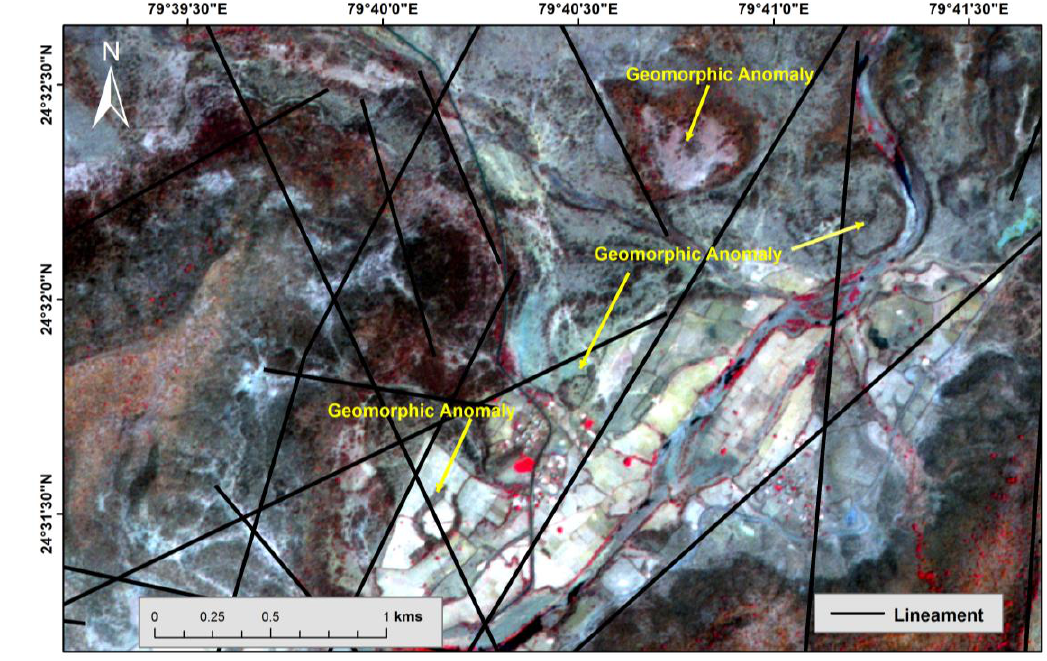
Figure 4: Identification of geomorphic anomaly on satellite